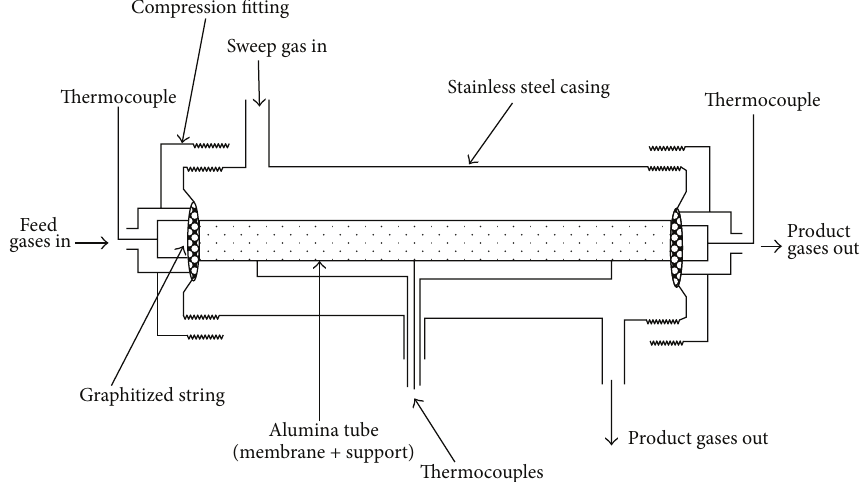
Figure 8: Ceramic membrane